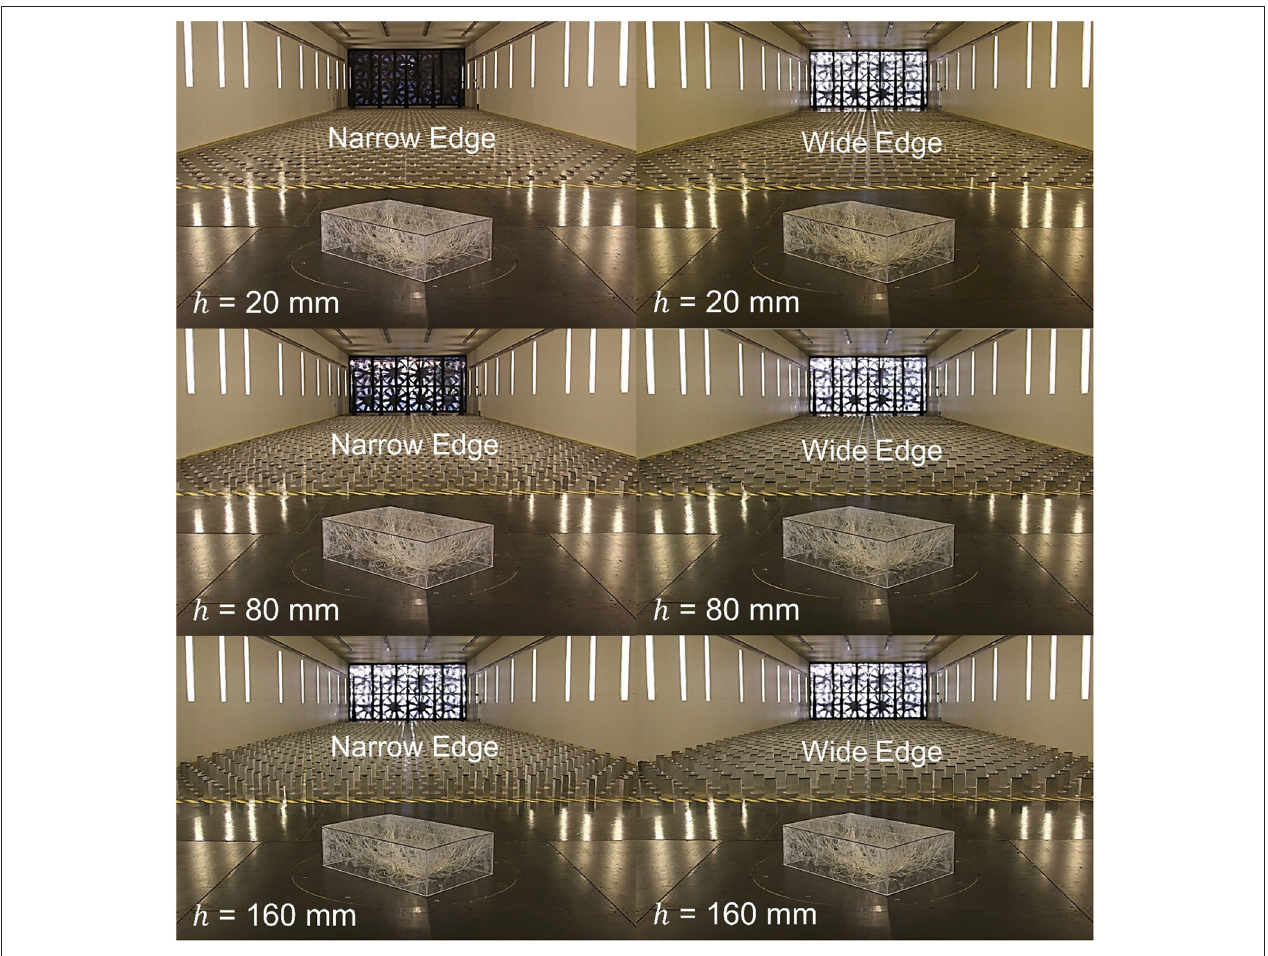
FIGURE 2 | Six representative upwind terrain configurations for the UF 1:20 WERFL building model oriented at a 45 ◦ (cornering) wind direction.